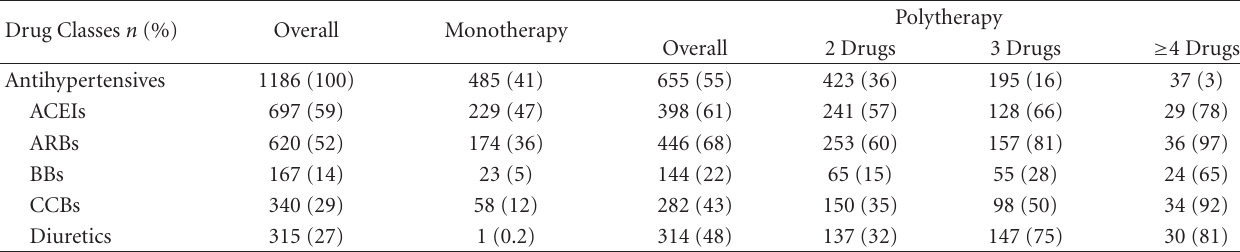
Table 2: Pattern of Antihypertensive among patients with single or multiple drugs